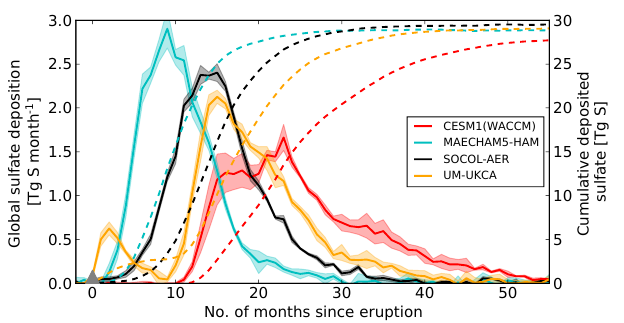
Figure 5. Global volcanic sulfate deposition (TgS month − 1 ) (solid lines – left axis) and global cumulative deposited sulfate (TgS) (dashed lines – right axis) for each model (colours). Ensemble mean is shown by the solid line; shading marks 1 SD. The grey triangle marks the start of the eruption (1 April 1815). Table 4. Global cumulative deposited sulfate (TgS) from dry and wet processes for each model (ensemble mean). Model Dry Wet Total deposition deposition deposition CESM1(WACCM) 2.4 25.4 27.8 MAECHAM5-HAM 0.2 28.7 28.9 SOCOL-AER 1.0 28.5 29.5 UM-UKCA 3.7 25.4 29.1